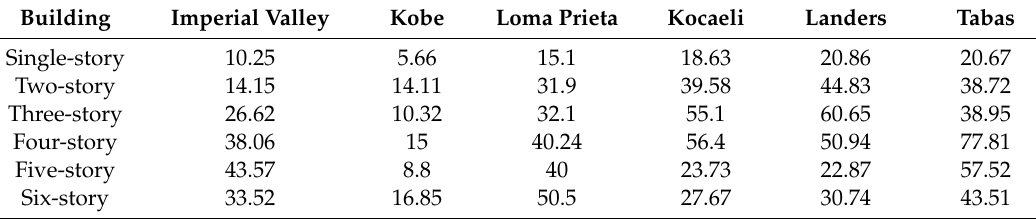
Table 2. Peak lateral displacements of buildings under di ff erent earthquake records (cm).